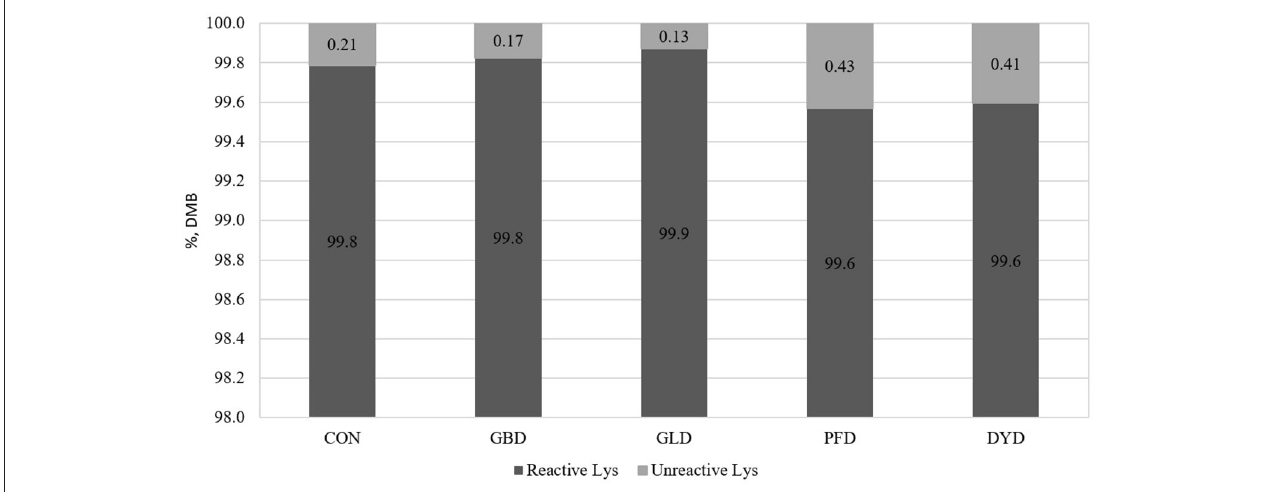
FIGURE 2 | Reactive lysine content in canine diets containing legumes or yeast as the primary protein source. DMB, Dry matter basis; CON, Poultry by-product meal control; GBD, Garbanzo bean; GLD, Green lentil; PFD, Peanut flour; DYD, Dried yeast.